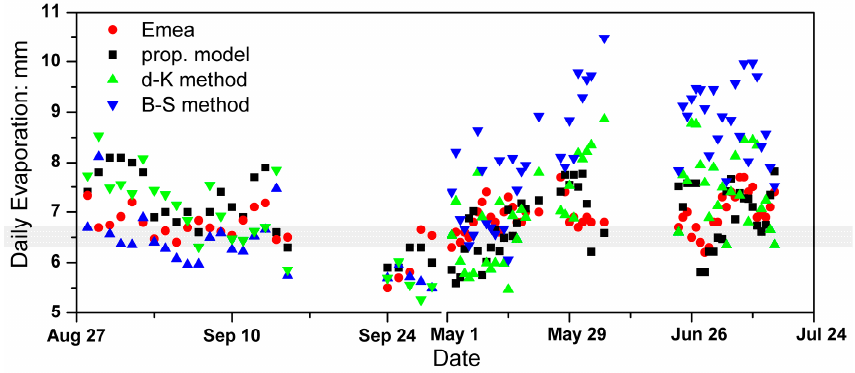
Figure 5. Comparisons of results by the three methods and measurement. Table 5. Inter-comparison of statistical indexes of evaporation methods.